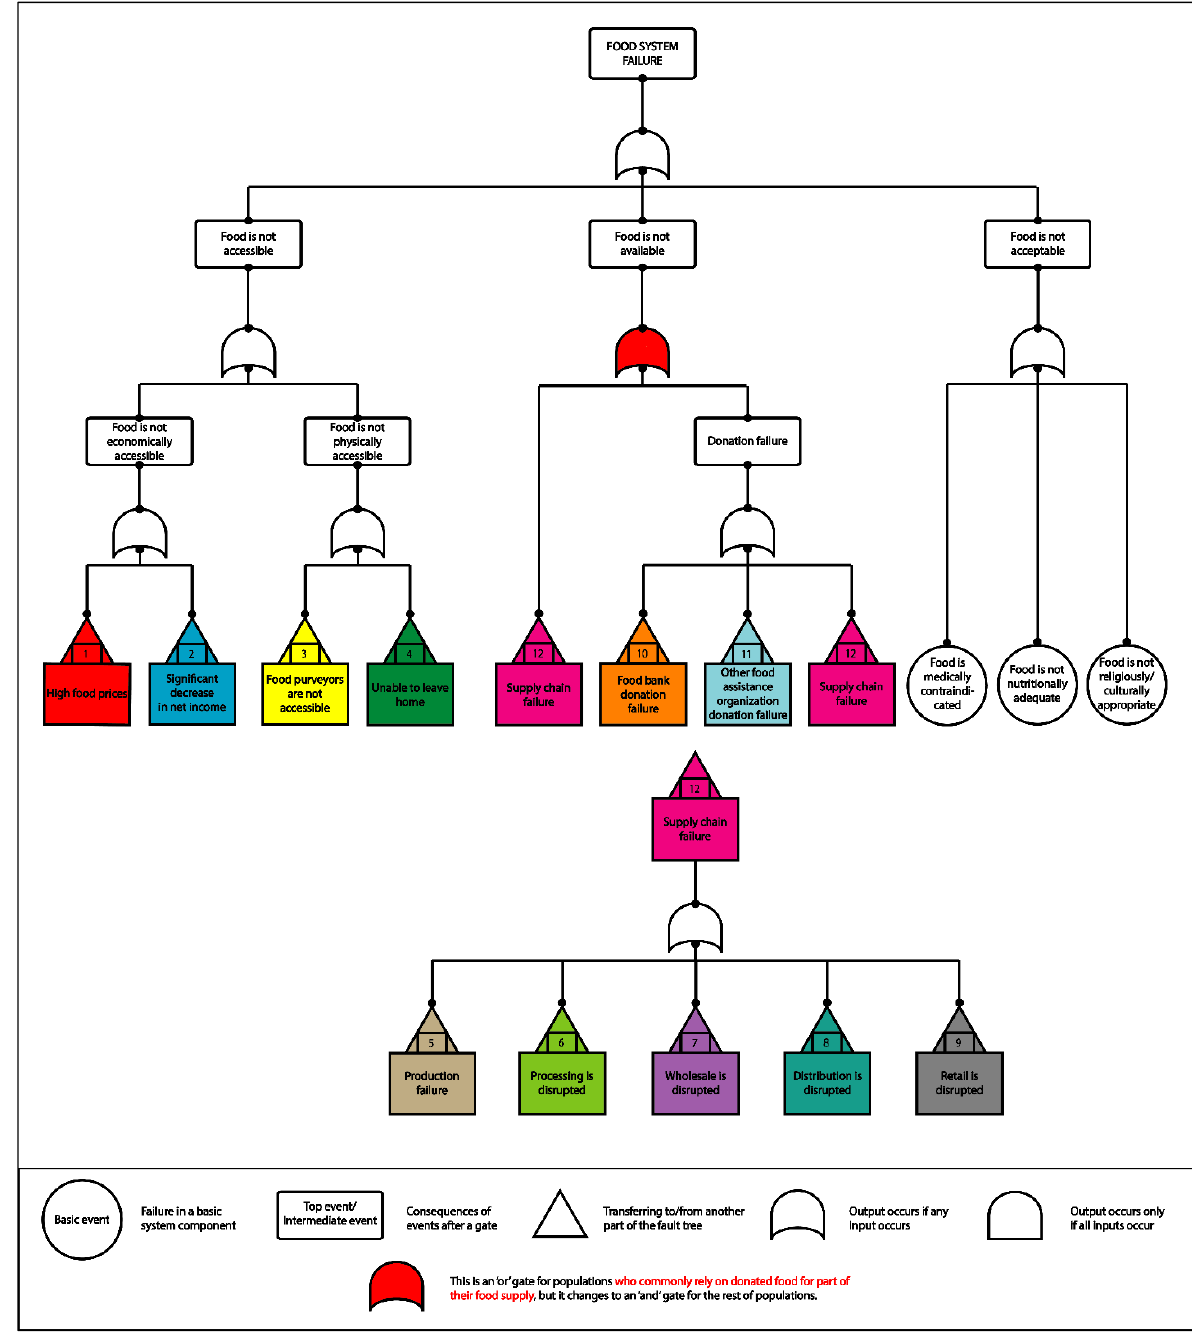
Figure 3. Framework for Conceptualizing Food System Vulnerabilities Events that lead to inadequate access, availability, or acceptability of food theoretically contribute to increased food insecurity and a food system